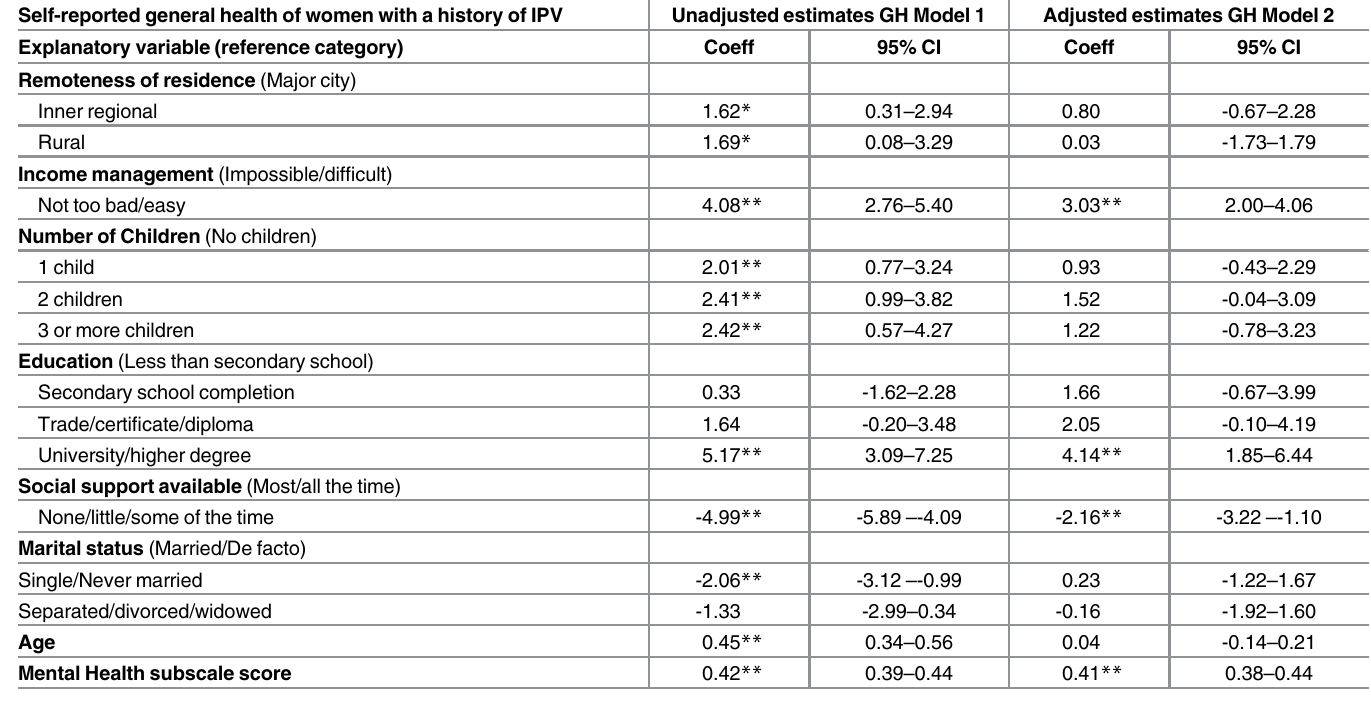
Table 2. Unadjusted and adjusted GEE models of factors associated with SF-36 General Health scores in women with a history of IPV. Self-reported general health of women with a history of